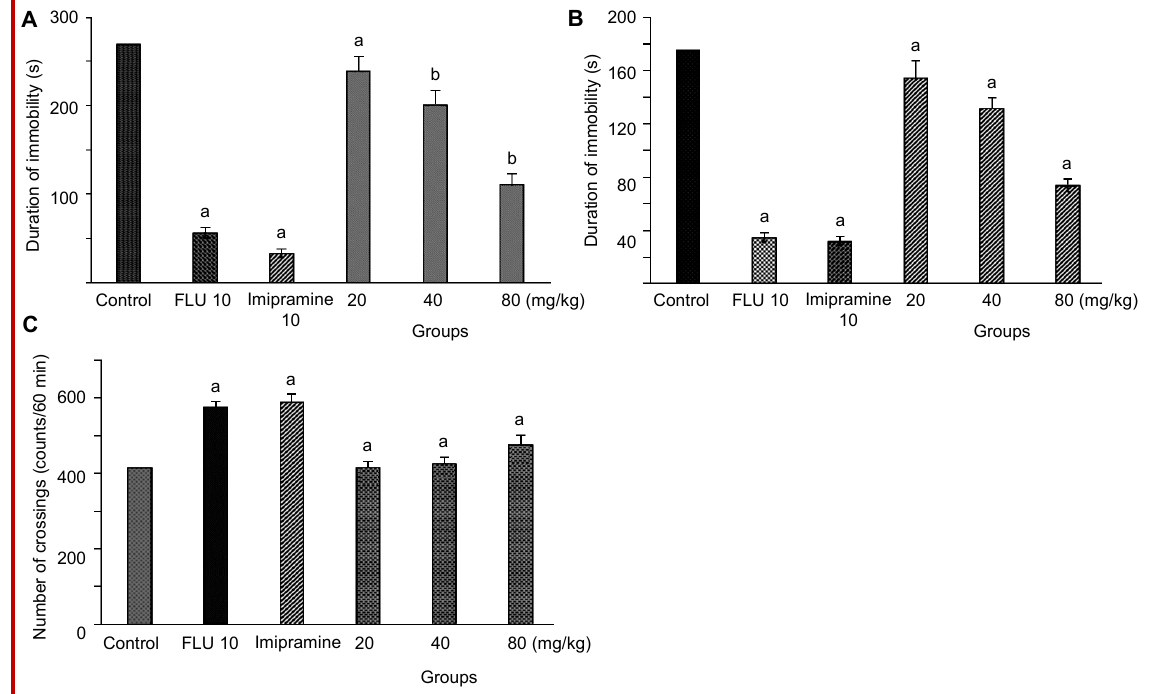
Figure 4: Effects of theaflavin-3-gallate (20, 40 and 80 mg/kg), fluoxetine (10 mg/kg) and imipramine hydrochloride (10 mg/kg) on immobility time in the mouse forced swim test (A), immobility time in the mouse tail suspension test (B) and number of cross- ings in open-field tests (C). Theaflavin-3-gallate was administered intraperitoneally 30 min before the test. Each column repre- sents the mean ± S.E.M. of immobility period (s) of 8 rats in each group (n = 8). a p<0.05 compared to control; b